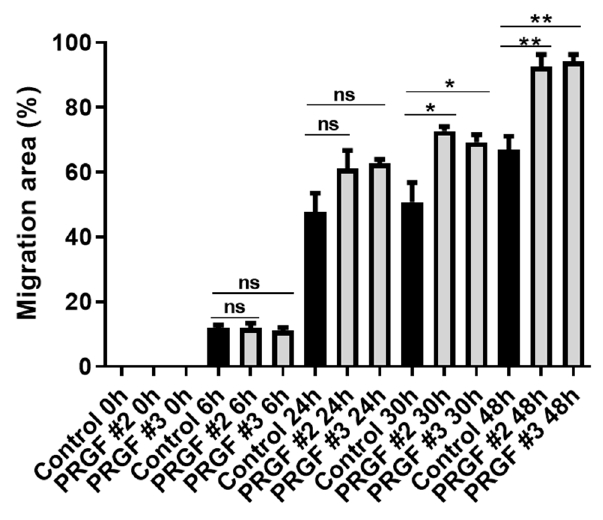
Figure 7. PRGF enhanced migration of human primary fibroblasts in scratch assays . Cultured human fibroblasts were Scheme 6. 24, 30 and 48 h. ( n = 3, * p < 0.05, ** p < 0.01, ns = non-significant, ANOVA with Bonferroni’s multiple comparisons test).